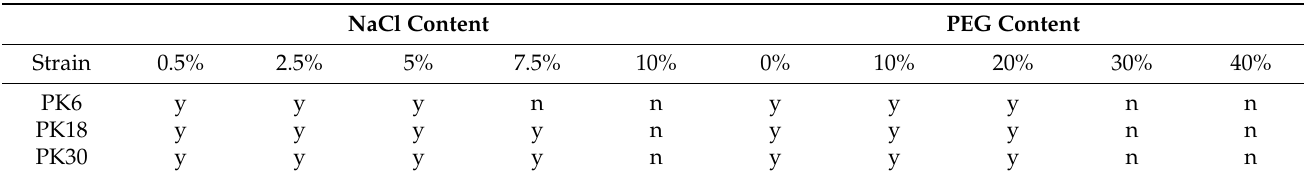
Table 2. Growth of bacterial strains on NGA with different NaCl levels. y = growth detected, n = growth not